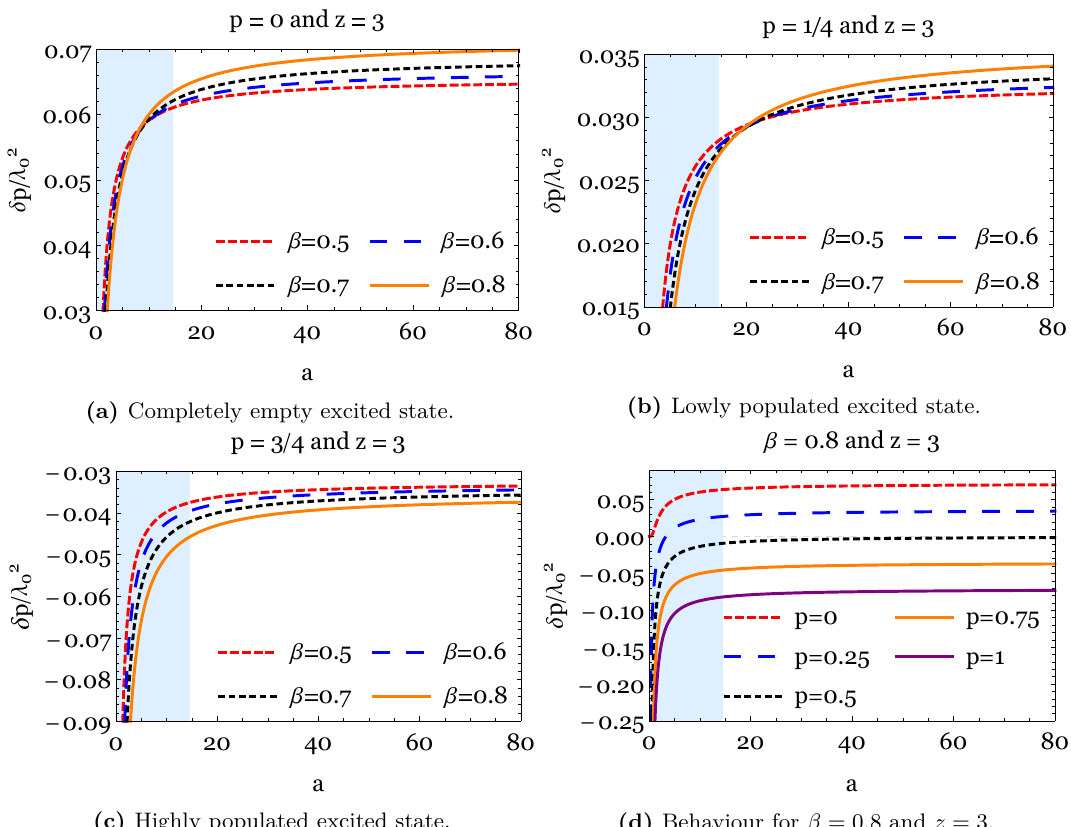
Figure 7. Behaviour of the transition probability with respect to reduced acceleration a in the far boundary regime for various values of p and β